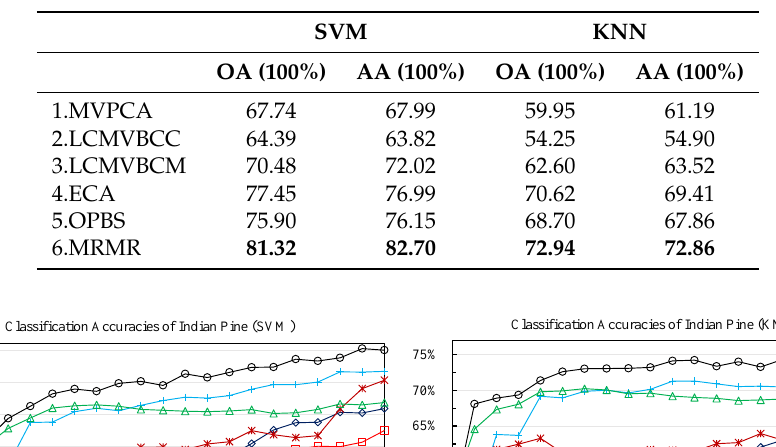
Table 1. Overall Accuracies and Average Accuracies of Using the Fifteen Bands Selected from the Indian Pine Dataset. (The bold denotes the best result).